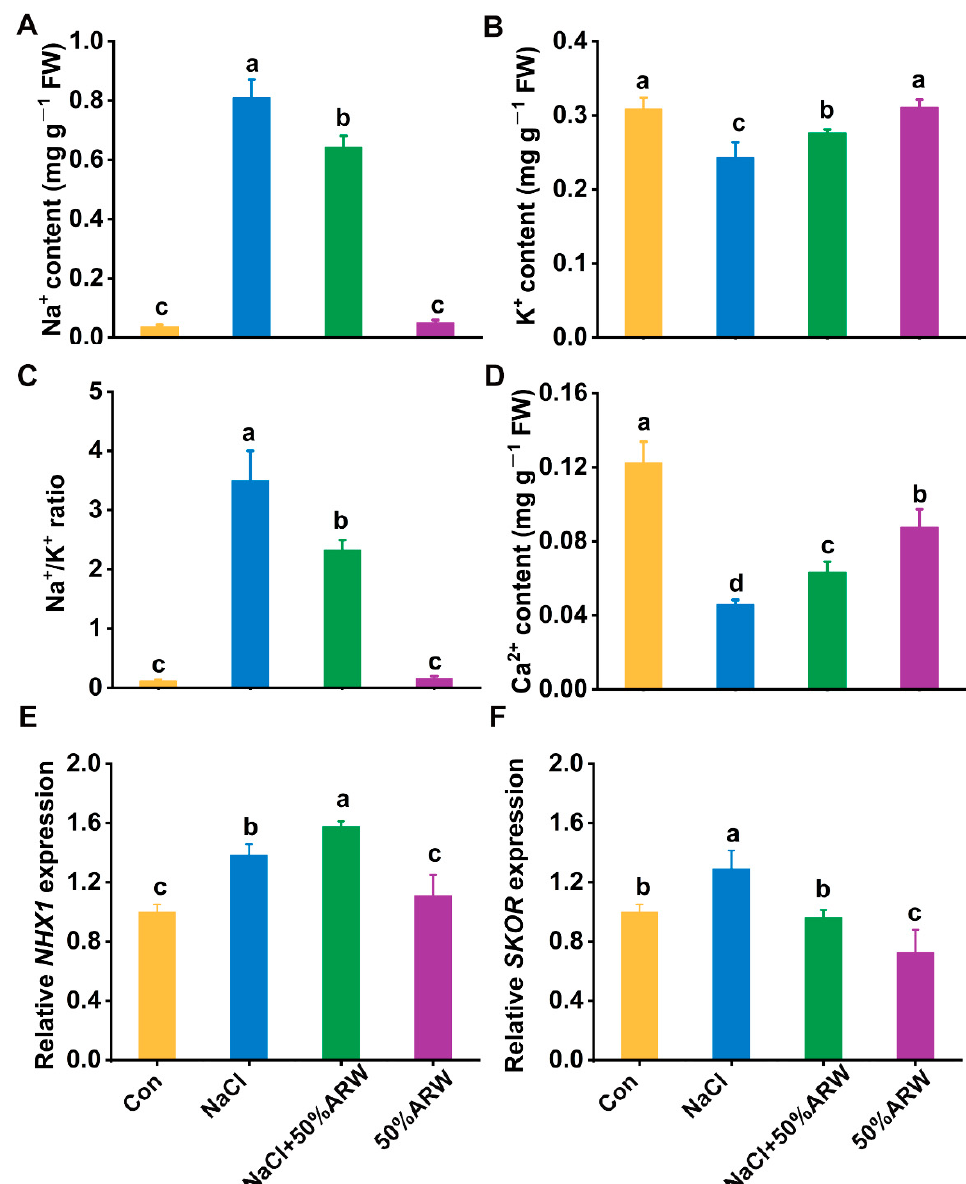
Figure 2. Changes in ion homeostasis in response to argon. After germination for 3 d, the Na + ( A ) and K + ( B ) contents in the seedlings, as well as the Na + /K + ratio ( C ), were determined. The Ca 2+ content ( D ) was also calculated. Changes in NHX1 ( E ) and SKOR ( F ) transcripts in seedlings were analyzed with qPCR. The error bars represent the SD. Bars with different letters (a–d) were significantly different at p < 0.05 according to Duncan’s multiple range test.